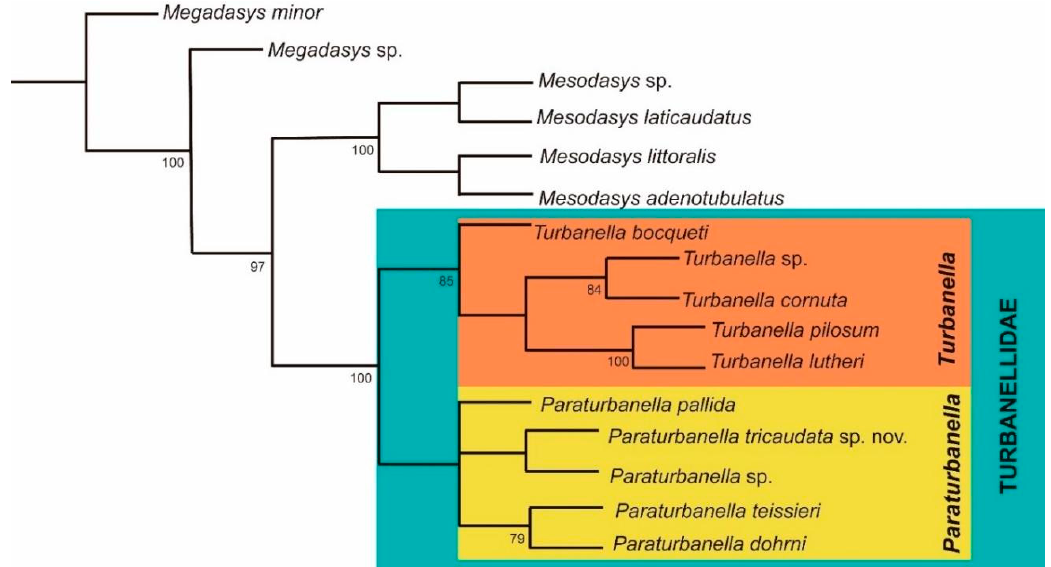
Figure 7. Maximum parsimony reconstruction based on molecular data (18S and 28S rDNA). Molecular dataset aligned in MAFFT. Numbers at nodes indicate bootstrap support (> 75).